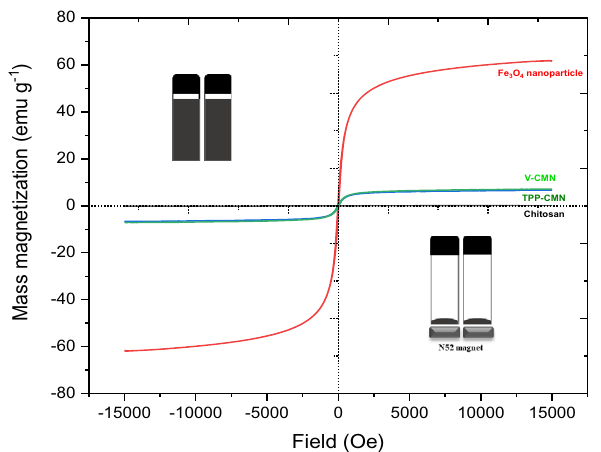
Figure 4. Magnetic hysteresis loop of chitosan, Fe 3 O 4 nanoparticle, TPP-CMN and V-CMN at room temperature (inset: magnetic separation of TPP-CMN and V-CMN nano-sorbents after treatment of